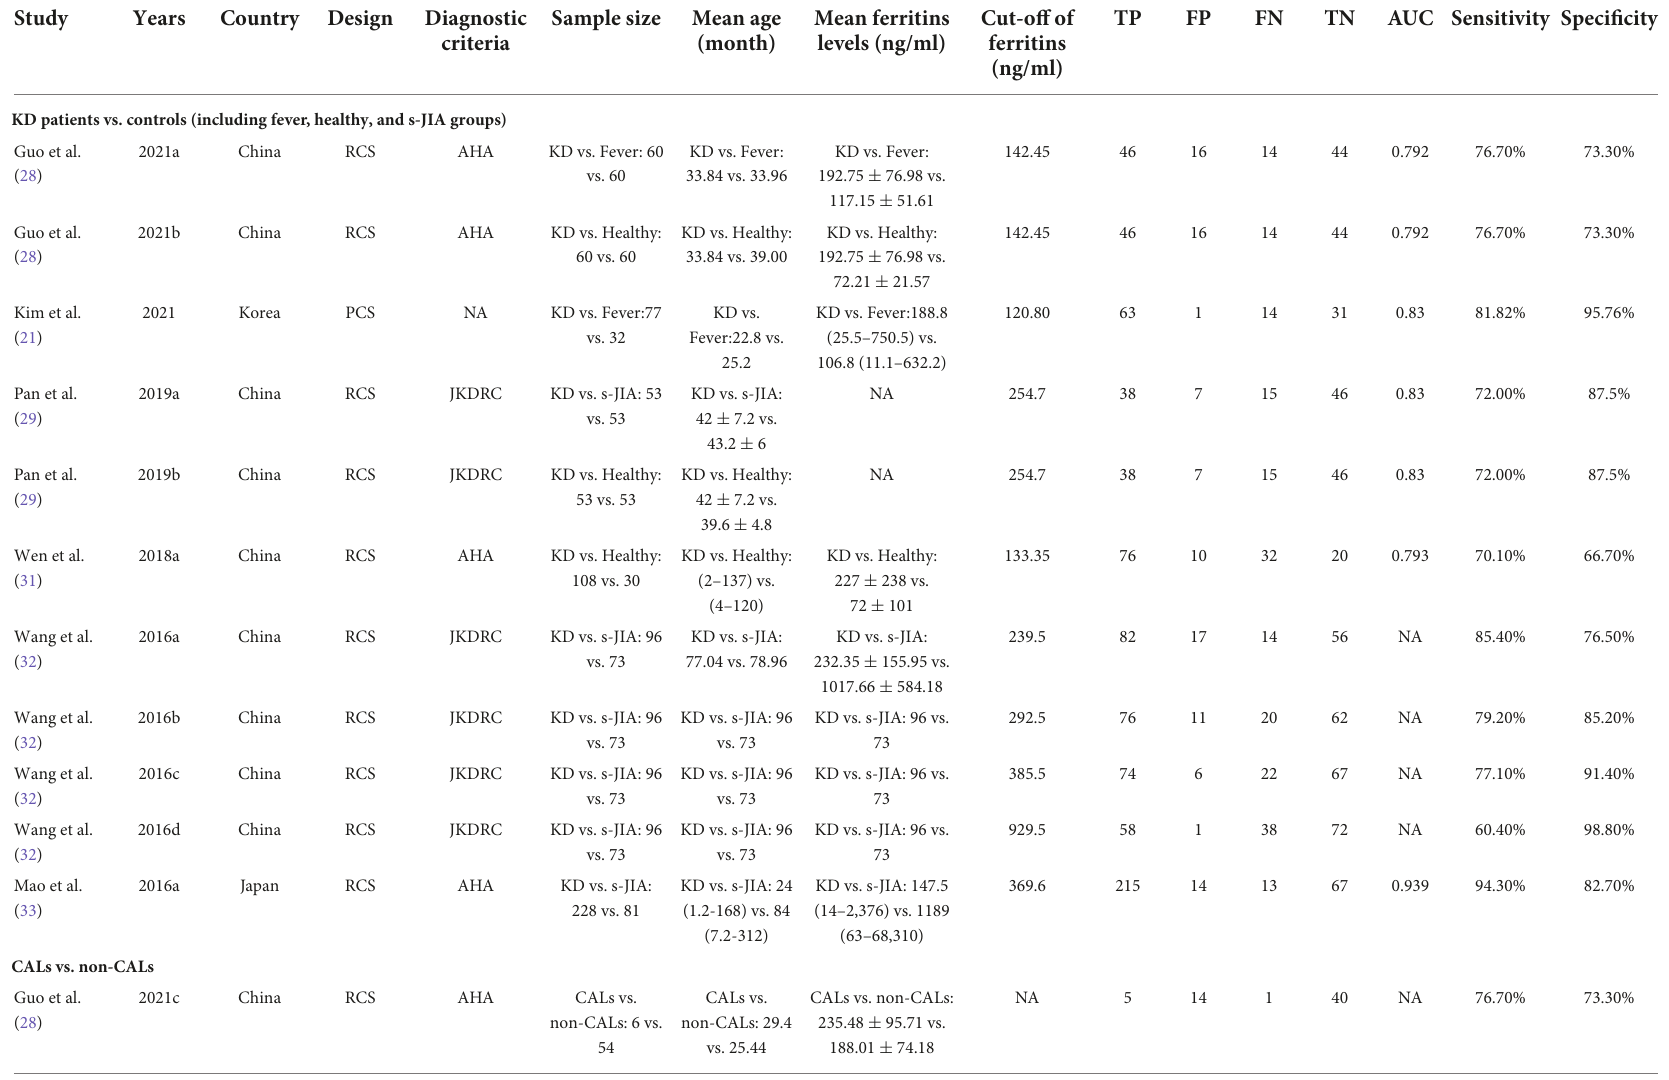
TABLE 2 Characteristics of studies in diagnostic